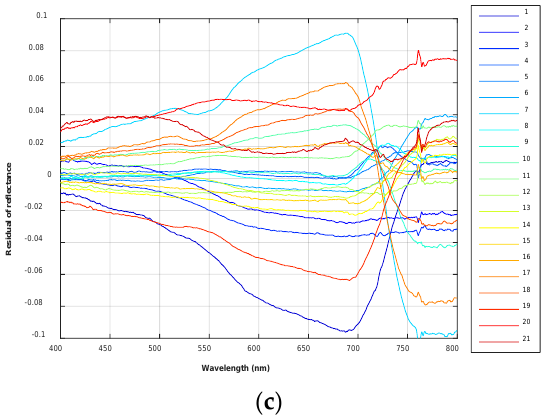
Figure 7. The observed ( a ) and predicted ( b ) reflectance spectra and the corresponding residuals ( c ). Each spectrum is given a random color.